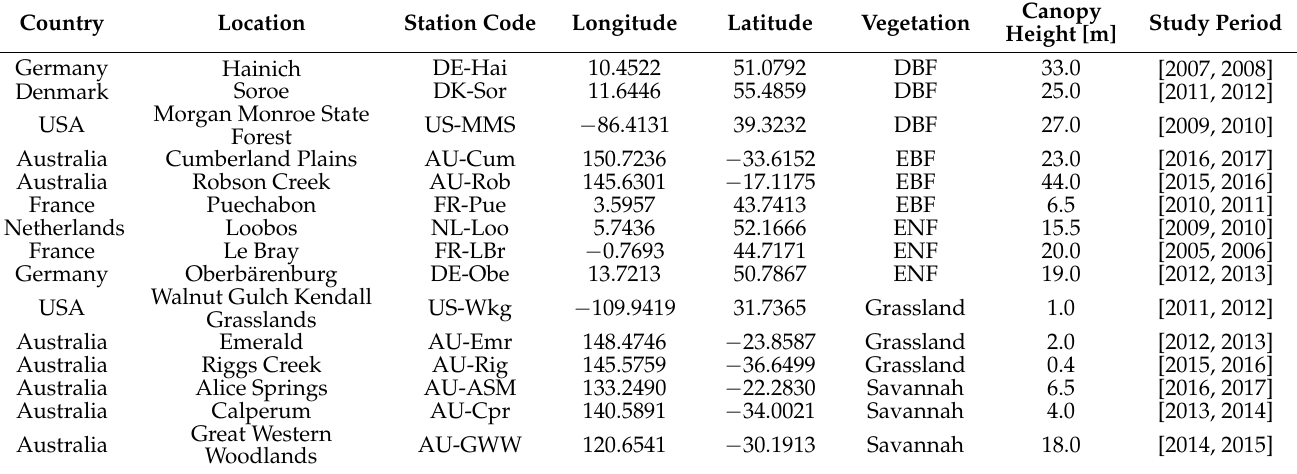
Table 2. Summarized description of the eddy covariance (EC) station sites used in this